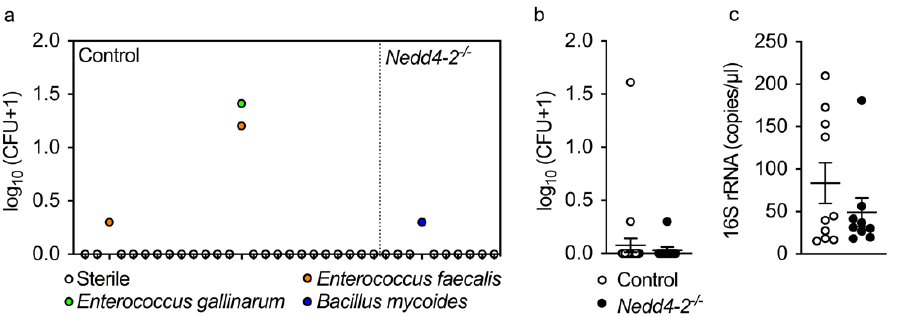
Figure 4. Bacterial species detected in BAL by bacterial culture and 16S rRNA quantitative PCR in neonatal mice with congenital deletion of Nedd4-2 and littermate controls: ( a ) Individual colony forming units (CFUs) for bacterial species cultured from BAL of 3-week-old congenital Nedd4-2 − / − mice and littermate controls. Each dot represents the result obtained from an individual mouse. ( b ) Summary of all CFUs in BAL of 3-week-old Nedd4-2 − / − mice and littermate controls. ( c ) Bacterial load determined by 16S rRNA analysis in BAL. n = 10–25 mice per group. Data are shown as mean ±